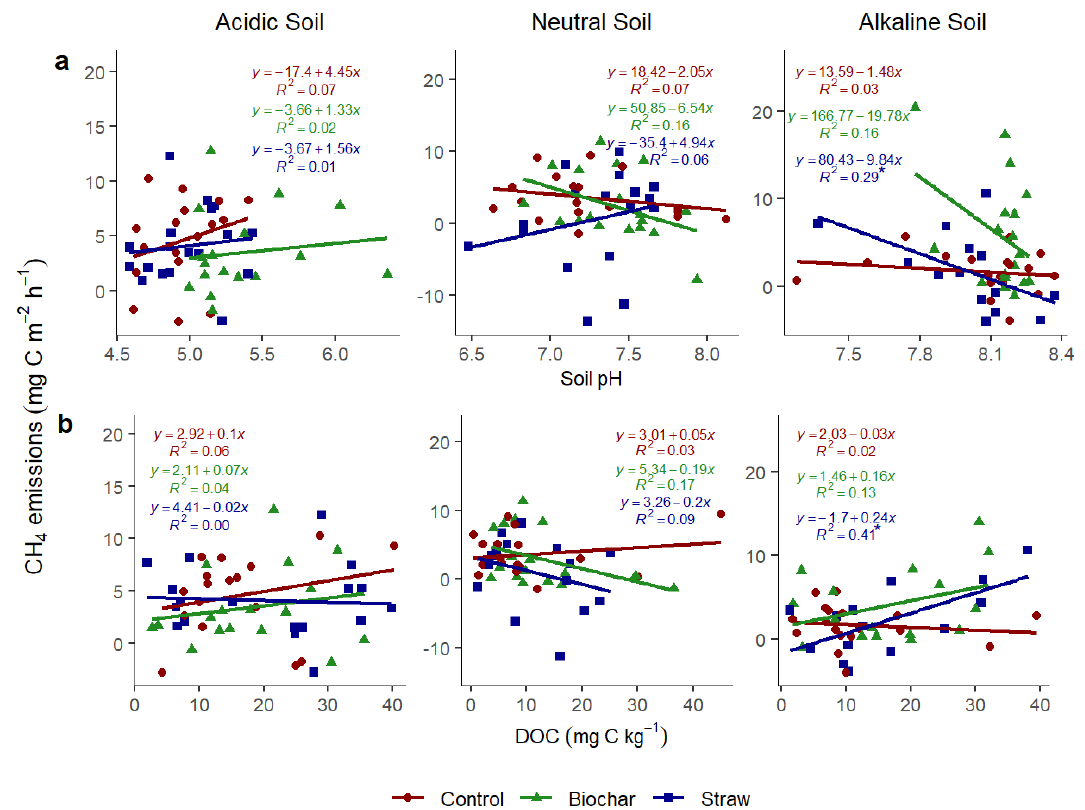
Figure 10. The relationships between CH 4 emissions and ( a ) soil pH and ( b ) soil dissolved organic carbon in soils of different pH treated with biochar and straw averaged over 18 days. Note: (*) shows that the strength of the relationship is significant at p -value ≤ 0.05. The axes of the different natural soil pH values are on different scales.